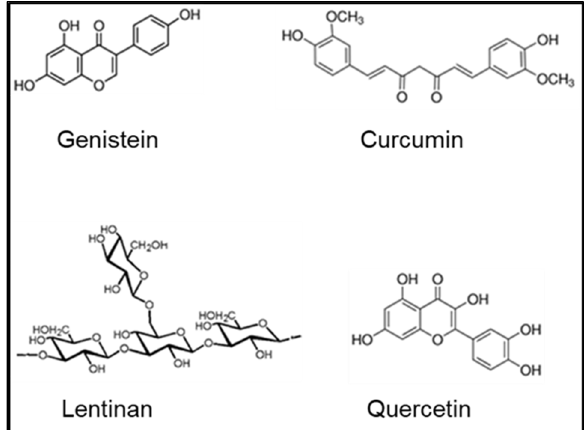
Figure 1. Chemical structures of tested nutraceuticals.